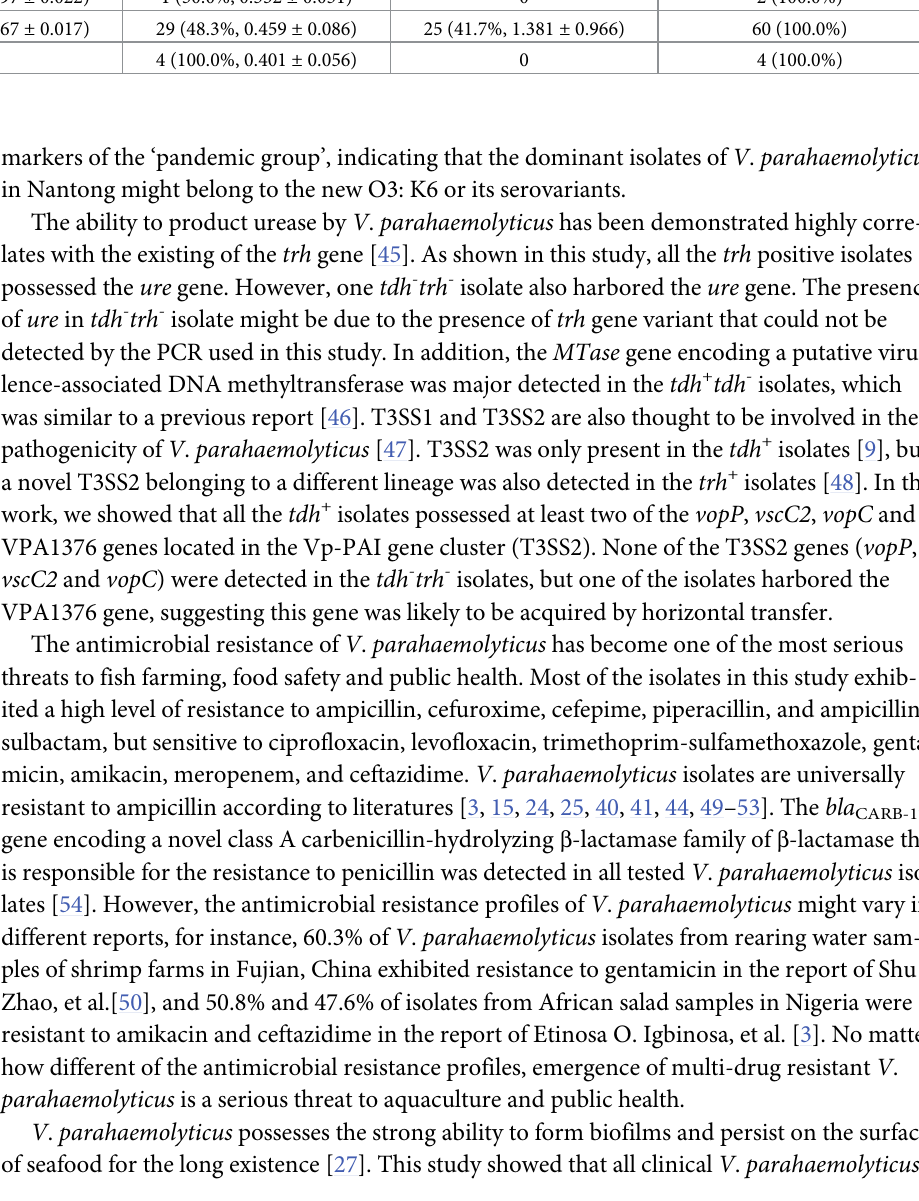
Table 4. Swimming motility of V . parahaemolyticus isolates. Isolates Total